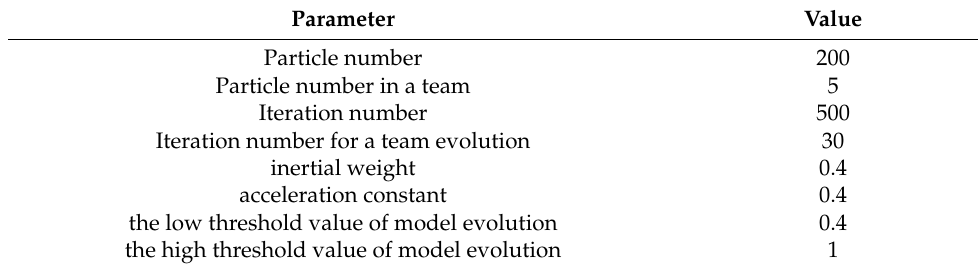
Table 12. Evolution parameters chosen for TPSO algorithm.